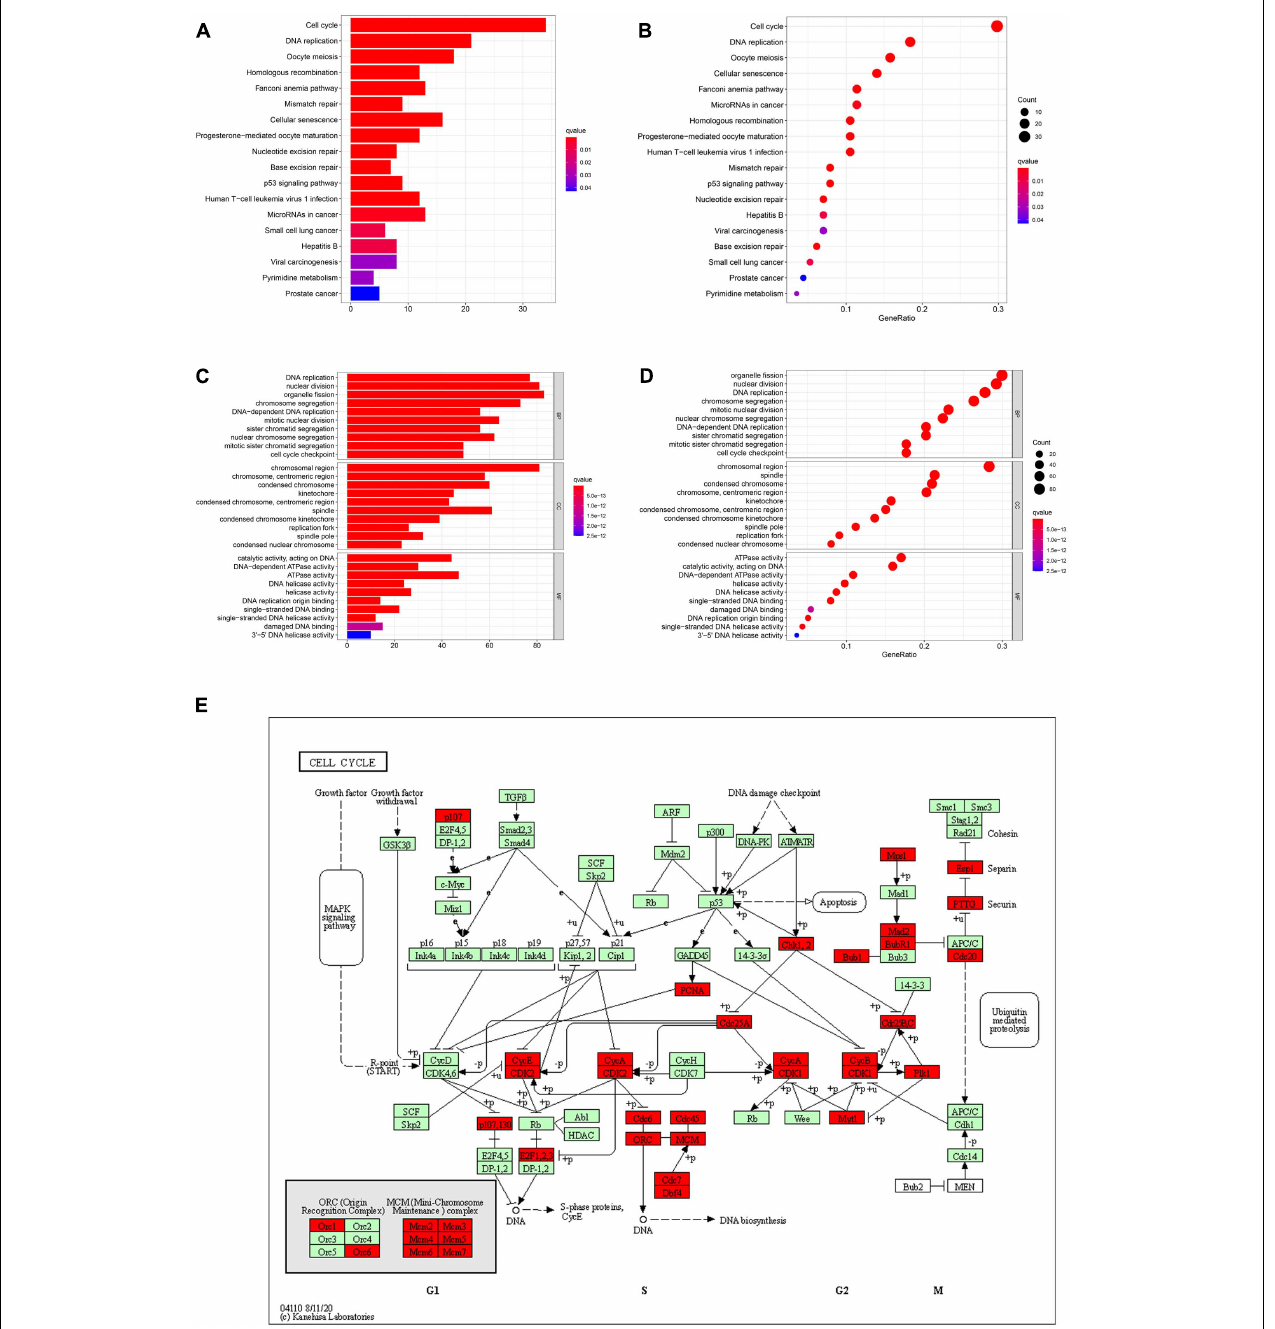
FIGURE 7 | Bar graphs, bubble diagrams, and cell cycle pathway map. (A) Bar graph of KEGG enrichment analysis. (B) Bubble diagram of KEGG enrichment analysis. (C) Bar graph of GO enrichment analysis. (D) Bubble diagram of GO enrichment analysis. (E) Cell cycle pathway map; the co-expression genes of NUSAP1 were mainly existed in S phase and G2/ M phase of the cell